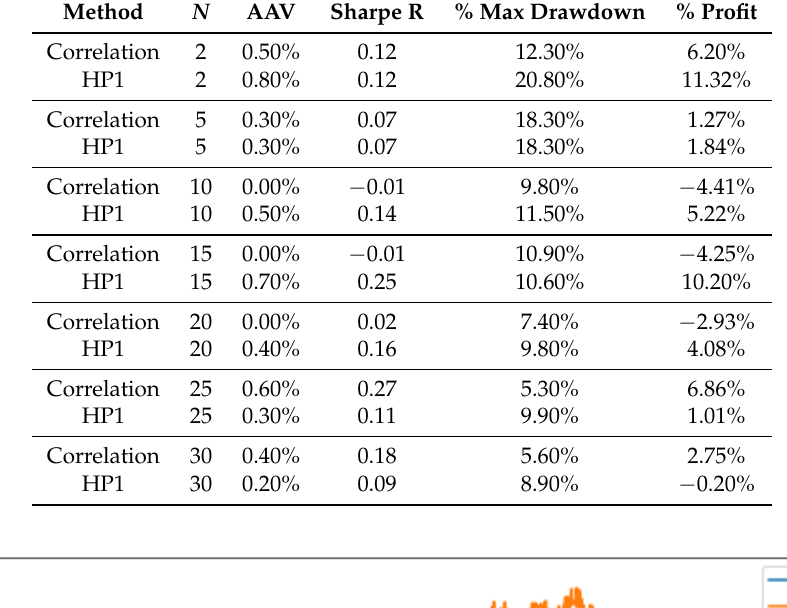
Table 2. Results obtained for the period 2000–2018, where N is the number of pairs; AAV is the average annualized return; Sharpe R is the Sharpe Ratio and Profit is the profitability for the full period with transaction costs.